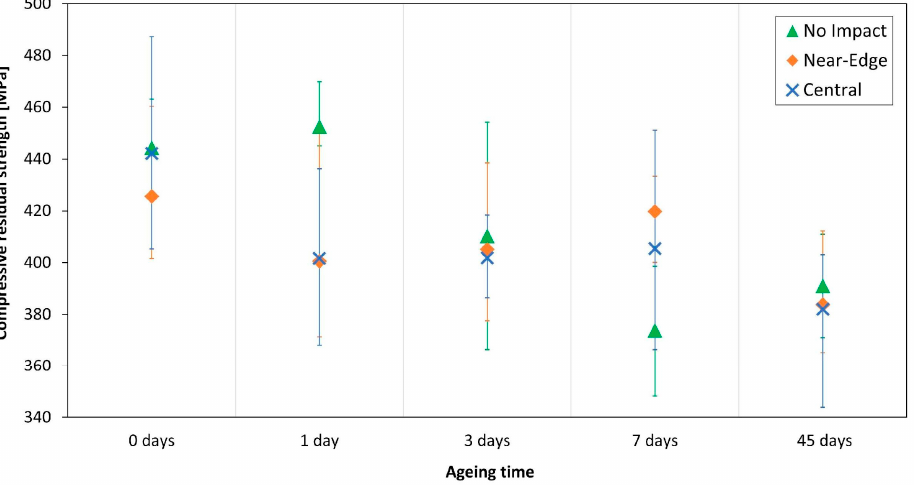
Figure 6. Compressive residual strength. Table 4. Compressive residual strength results (values reported in [MPa]).